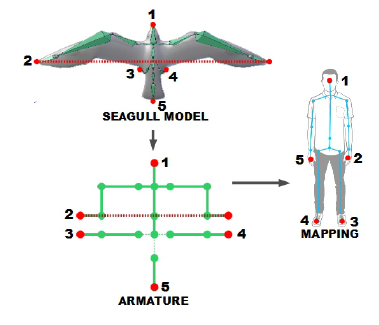
Figure 9. Mapping of the human skeleton onto the armature used to animate a snake model (a video is available at http://youtu. be/1ROz0mNgt8g ).